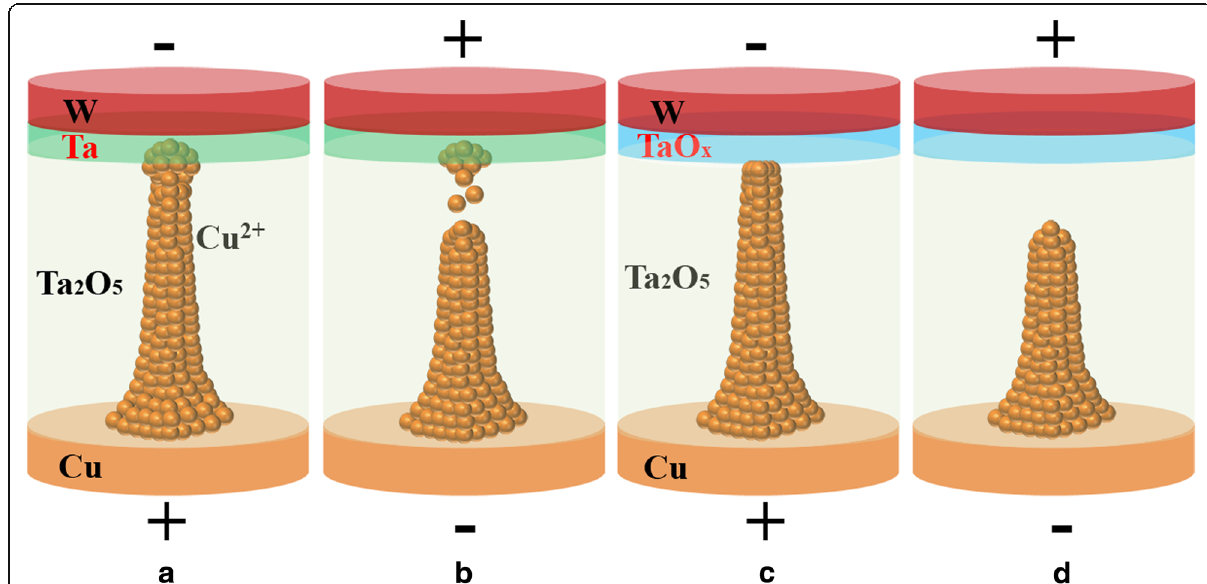
Fig. 6 The physical modeling for the switching behavior of the annealed and un-annealed devices. The a Set and b RESET process for the un-annealed device with the structure of Cu/Ta 2 O 5 /Ta/W. c Set and d RESET process for the annealed device with the structure of Cu/Ta 2 O 5 / TaO x /W. The filament overgrowth is suppressed by the TaO x layer formed during the annealing